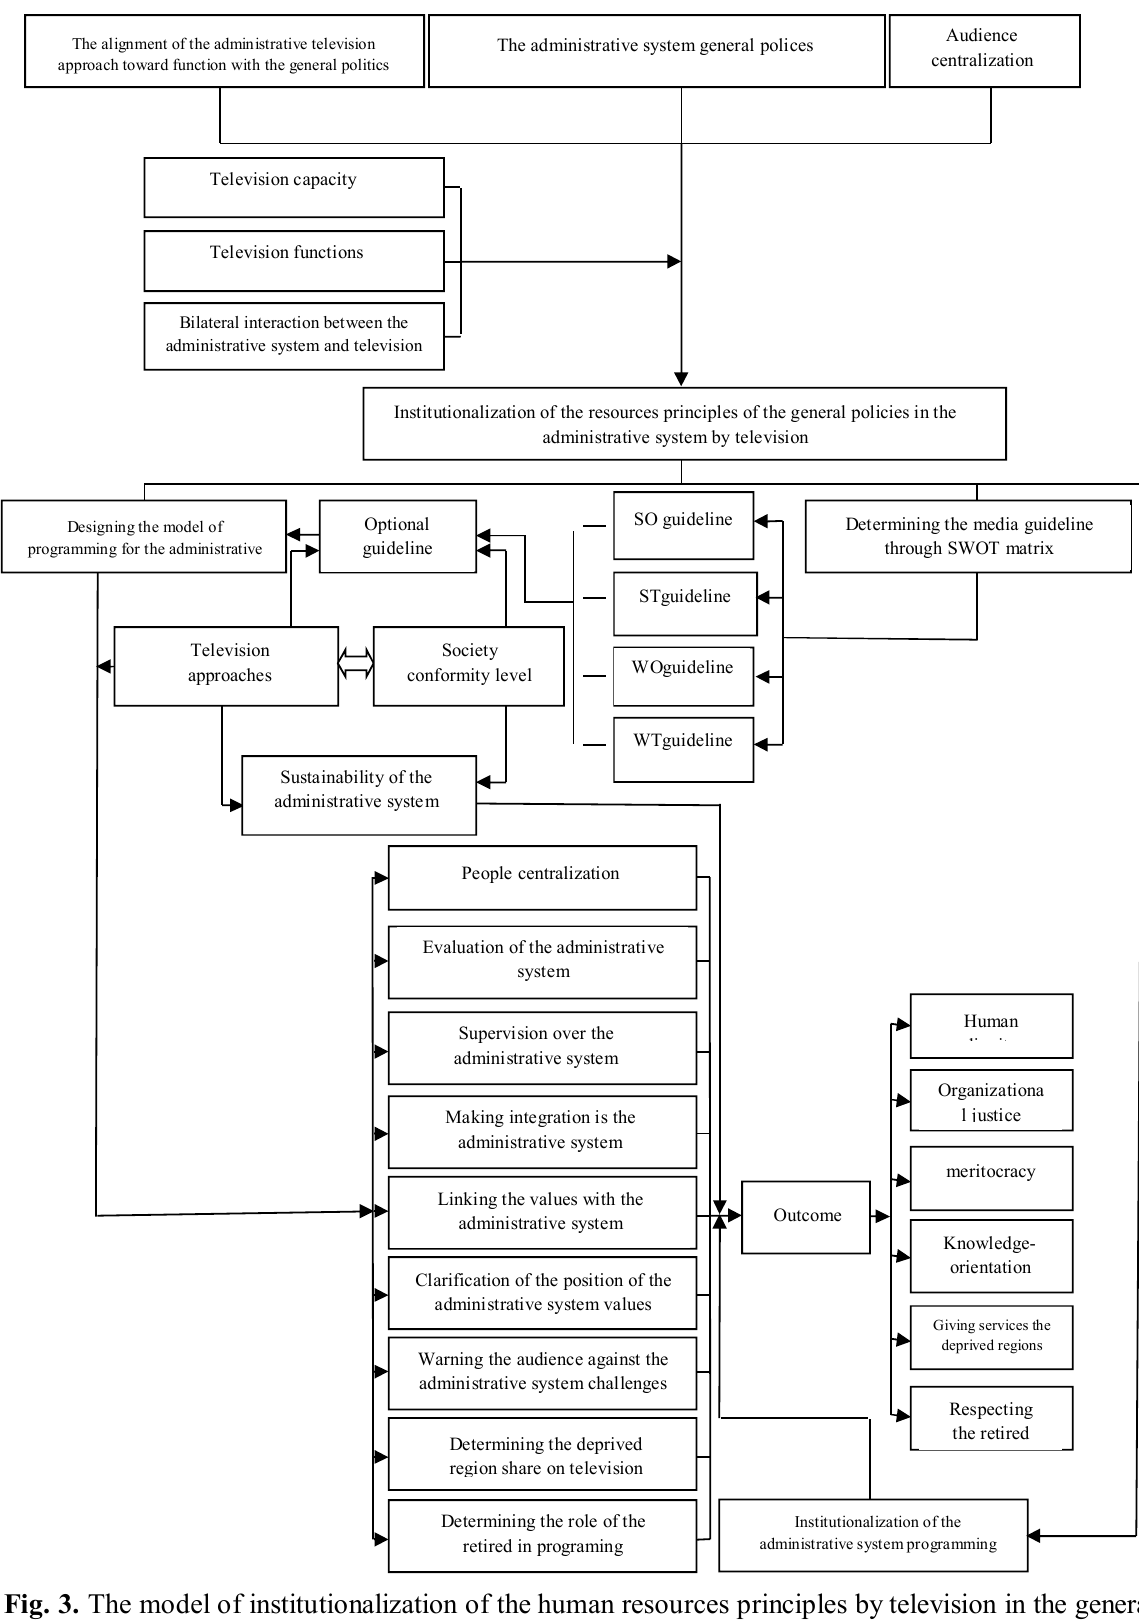
Fig. 3. The model of institutionalization of the human resources principles by television in the general policies of administrative